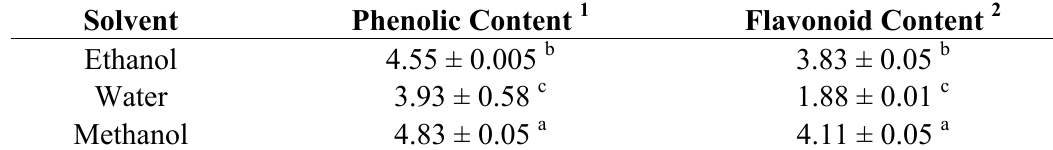
Table 1. Total phenolic and flavonoids content of Citrus aurantium